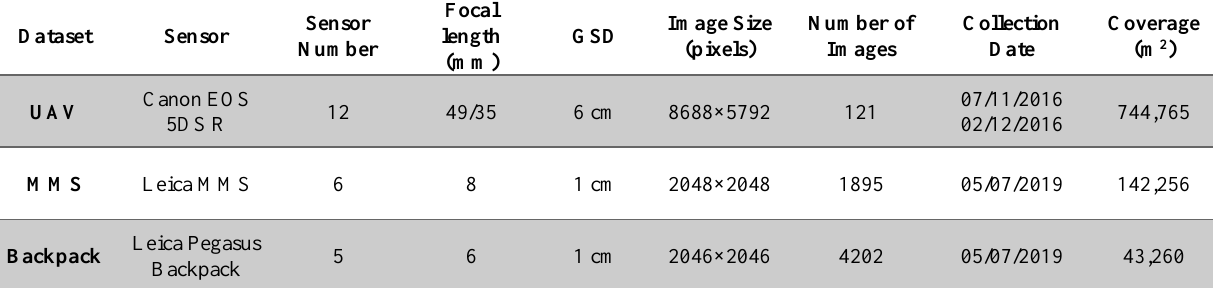
Table 1. Information of the dataset used for experimental